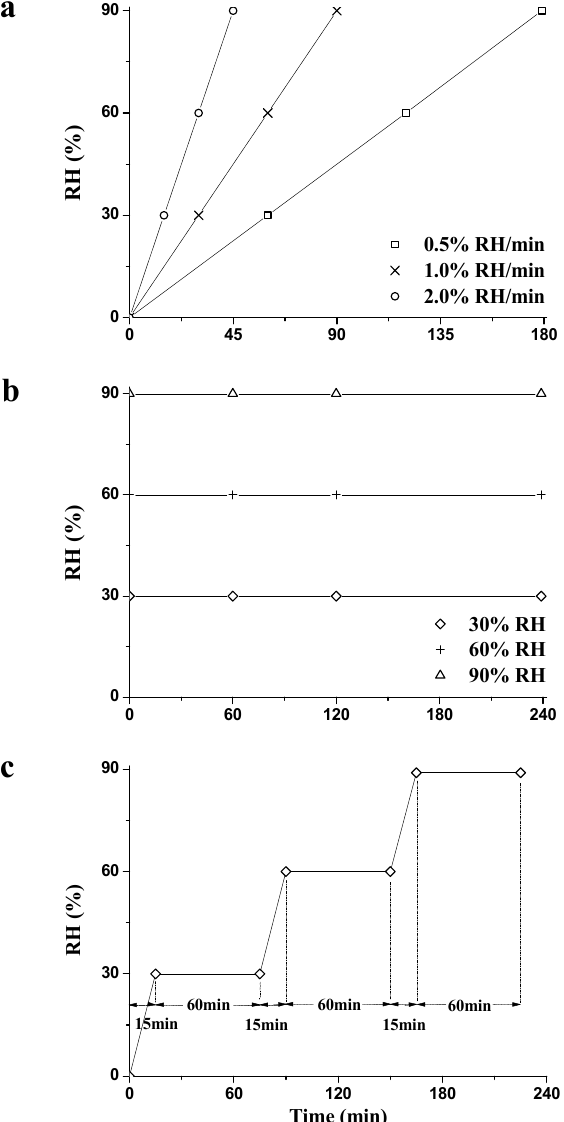
Figure 3. Outline of the experimental setup for the RH ramp ( a ); RH isohume ( b ); and RH step mode ( c